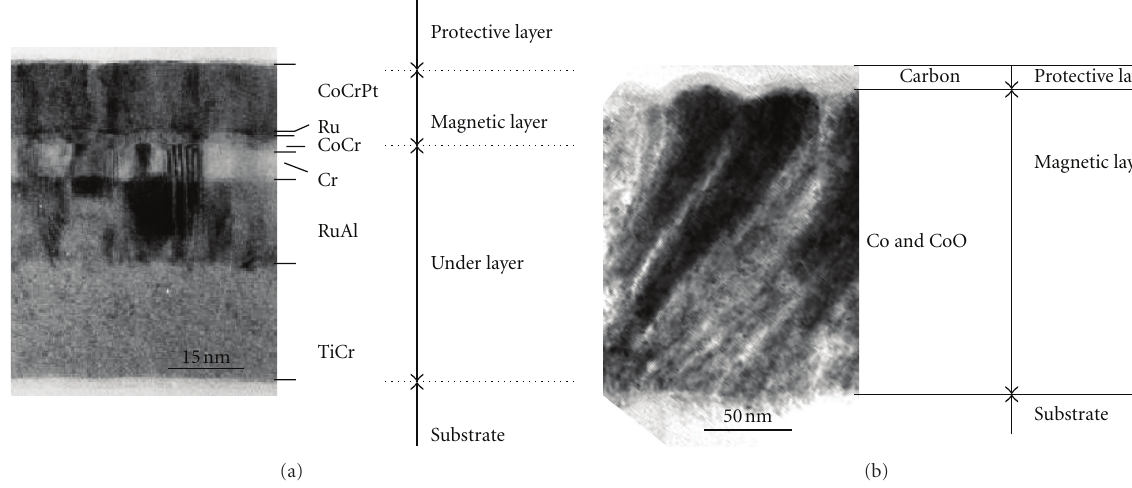
Figure 1: Cross-sectional TEM image of magnetic layer for rigid disk (a) and magnetic tape